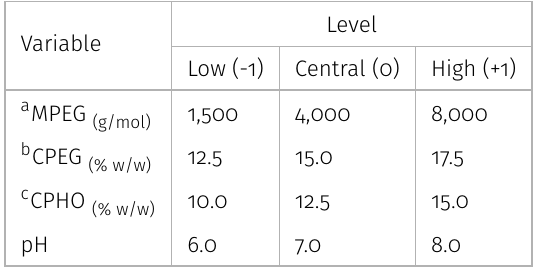
Table I. Factor levels of the 2 4 -experimental design used for the extraction of protease from Streptomyces parvulus DPUA 1573 by PEG/phosphate